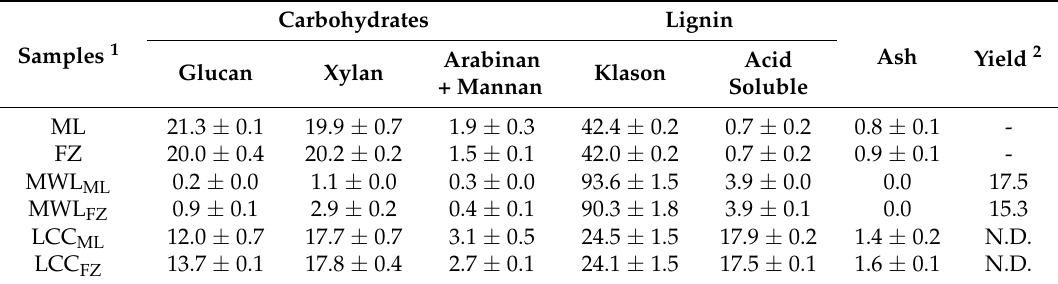
Table 1. Chemical composition and yield of ginkgo shells, MWLs, and LCCs